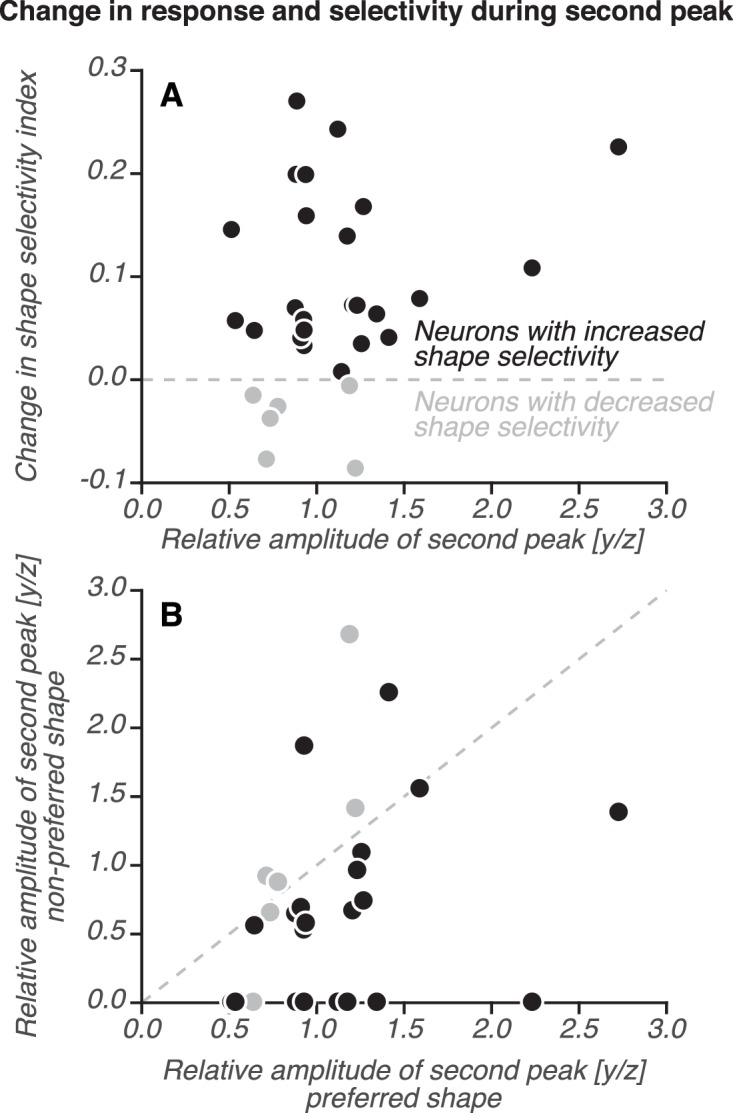
Relative response amplitude versus change in shape selectivity during the second peak for V4 neurons with two peaks.(A) Change in shape selectivity (second peak – first peak, ordinate) is plotted against the relative response amplitude (second peak/first peak, abscissa; same as y/z, see Figure 6—figure supplement 1B). For each peak, shape selectivity and response amplitude were measured during a 30 ms window centered on the second peak. Most neurons (24/30; black) showed an increase in shape selectivity during the second peak; this enhanced selectivity was observed even for neurons that responded more weakly during the second peak than the first, that is the relative amplitude of the second peak, y/z < 1.0. (B) Relative amplitude during the second peak for preferred (abscissa, as in A) and non-preferred stimuli (ordinate). For most neurons with increased shape selectivity during the second peak (black), the relative amplitude of the second peak was larger for the preferred than non-preferred stimuli. Neurons with decreased shape selectivity during the second peak (gray) lie close to, or above the diagonal. Thus, shape selectivity increased during the second peak, in large part because the size of the second peak relative to the first peak was smaller for non-preferred than preferred stimuli.